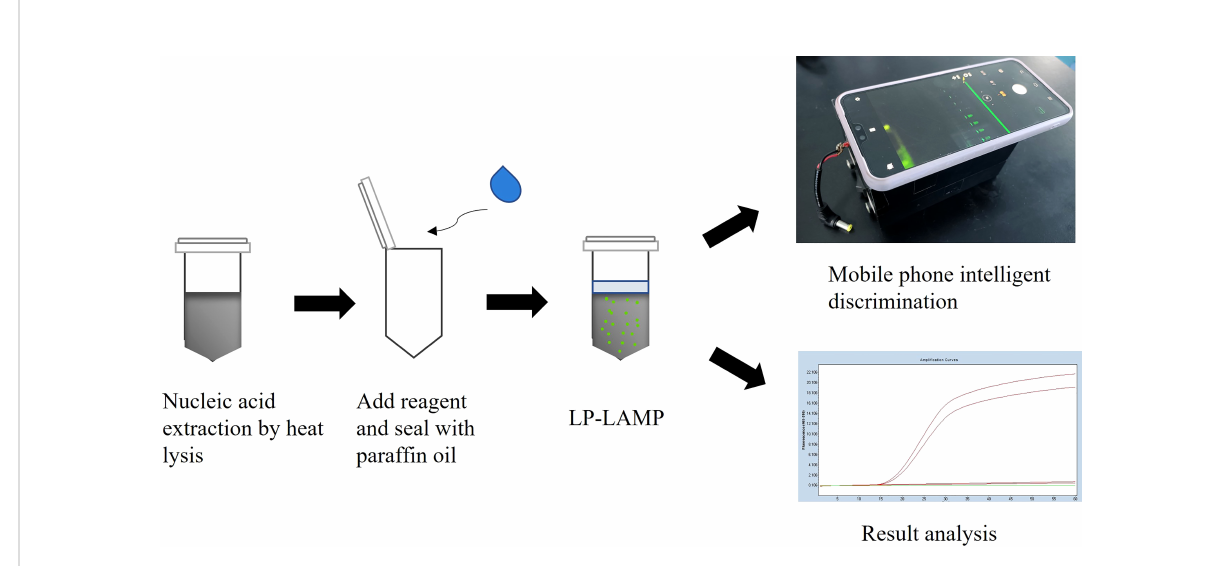
FIGURE 7 General work fl ow for the detection of Streptococcus suis serotype 2 or 14 strains by using